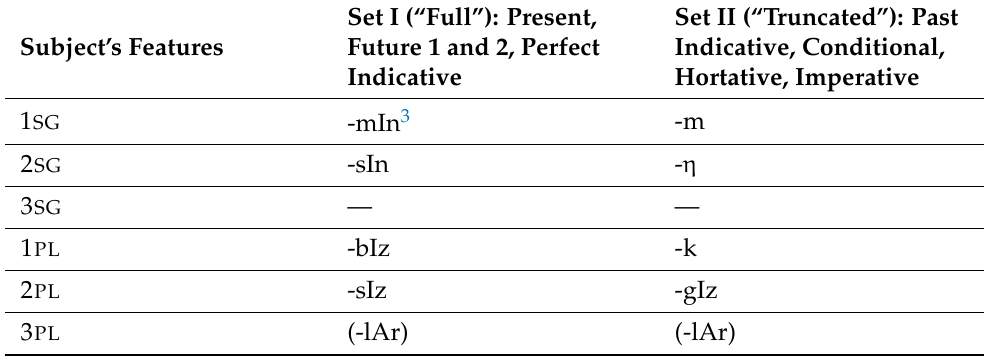
Table 1. Agreement markers in finite verbal forms (adapted from Zakiev 1995, vol. 2, p.